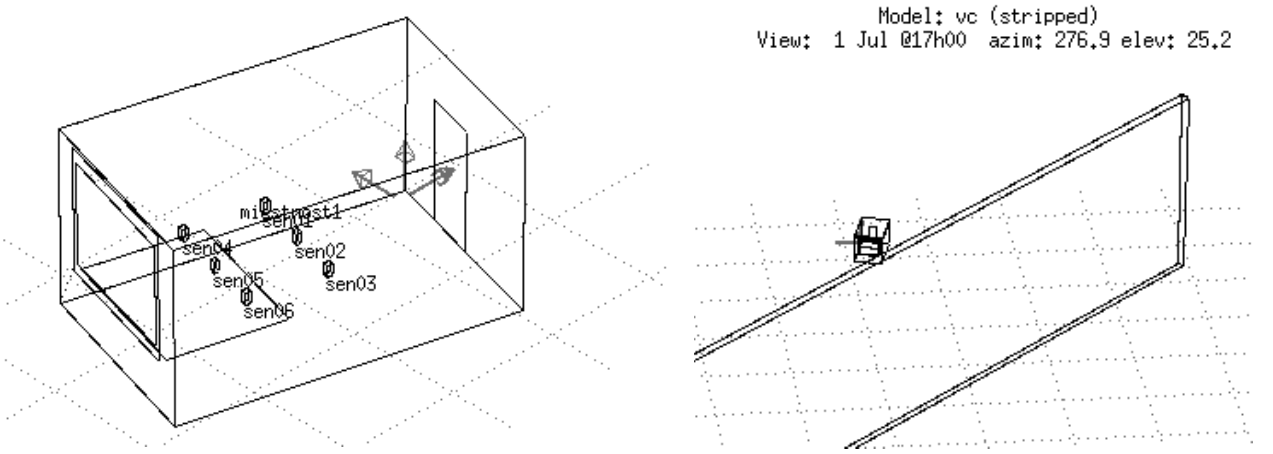
Figure 5. On the left a simplified simulation model of the office in ESP-r program with six MRT sensors, on the right a view from the sun on the office and an obstacle (row of trees) in ESP-r program. During the measurement period (28 June 2020–4 July 2020) two types of cooling